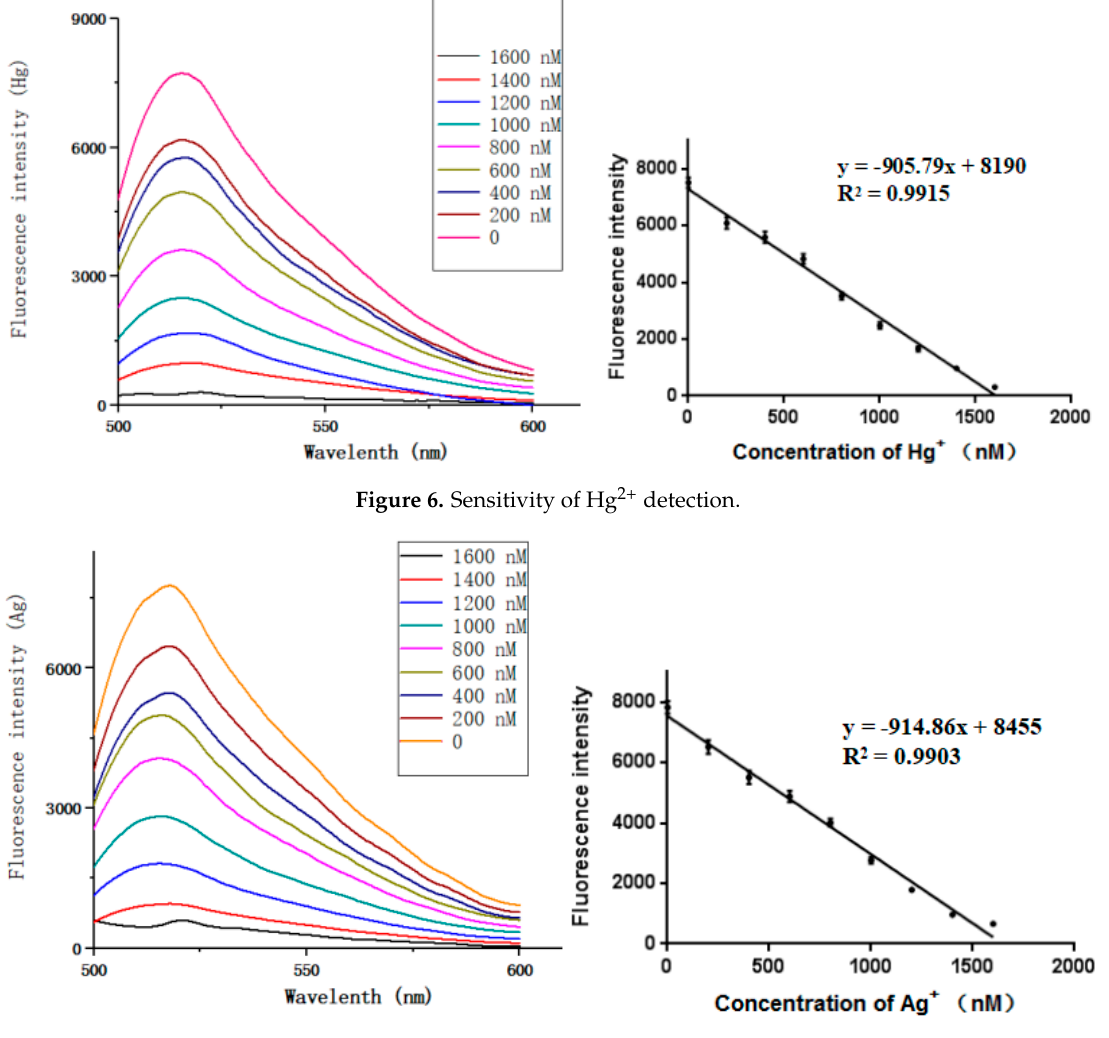
Figure 7. Sensitivity of Ag + detection.